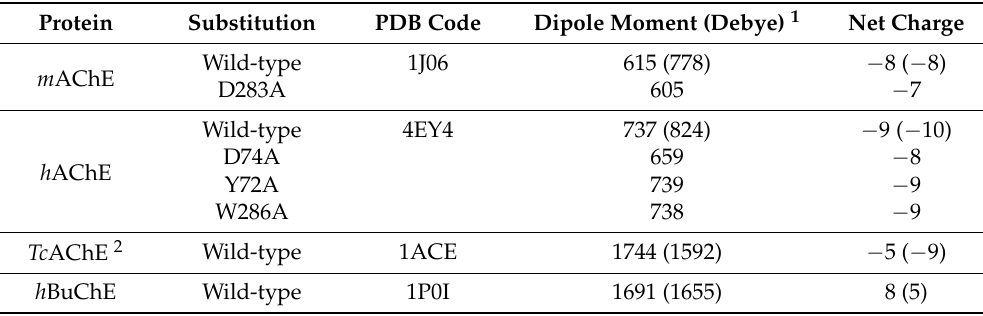
Table 3. Calculated dipole moment of wild-type and in silico mutated proteins. Protein Substitution PDB Code Dipole Moment (Debye) 1 Net Charge Wild-type 1J06 615 m AChE